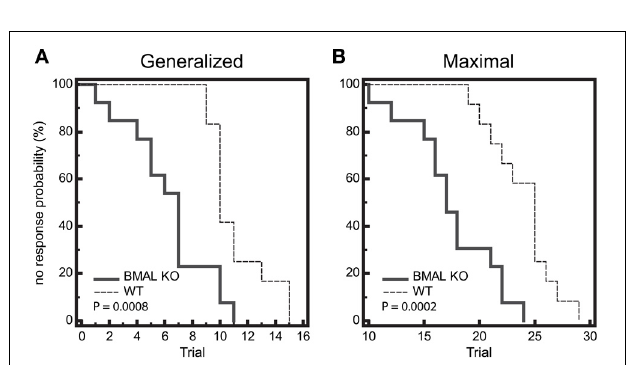
FIGURE 3 | Diurnal seizure susceptibility and baseline setpoint depends on BMAL1 expression. Time-of-day variation in (A) generalized (GEST) and (B) maximal (MEST) electroshock seizure threshold observed in wild-type (WT) mice is blocked in BMAL KO mice. (A) t -test (two-tail) WT GEST: ZT1 vs. ZT15 ∗ p < 0 . 05; WT vs. BMAL KO GEST: ZT1 vs. ZT1 ∗ p < 0 . 05, ZT15 vs. ZT15 ∗∗ p < 0 . 01. (B) t -test (two-tail) WT MEST: ZT1 vs. ZT15 ∗∗ p < 0 . 01; WT vs. BMAL KO GEST: ZT15 vs. ZT15 ∗∗∗ p < 0 . 001. Error bars = s.e.m. ZT, zeitgeber time.